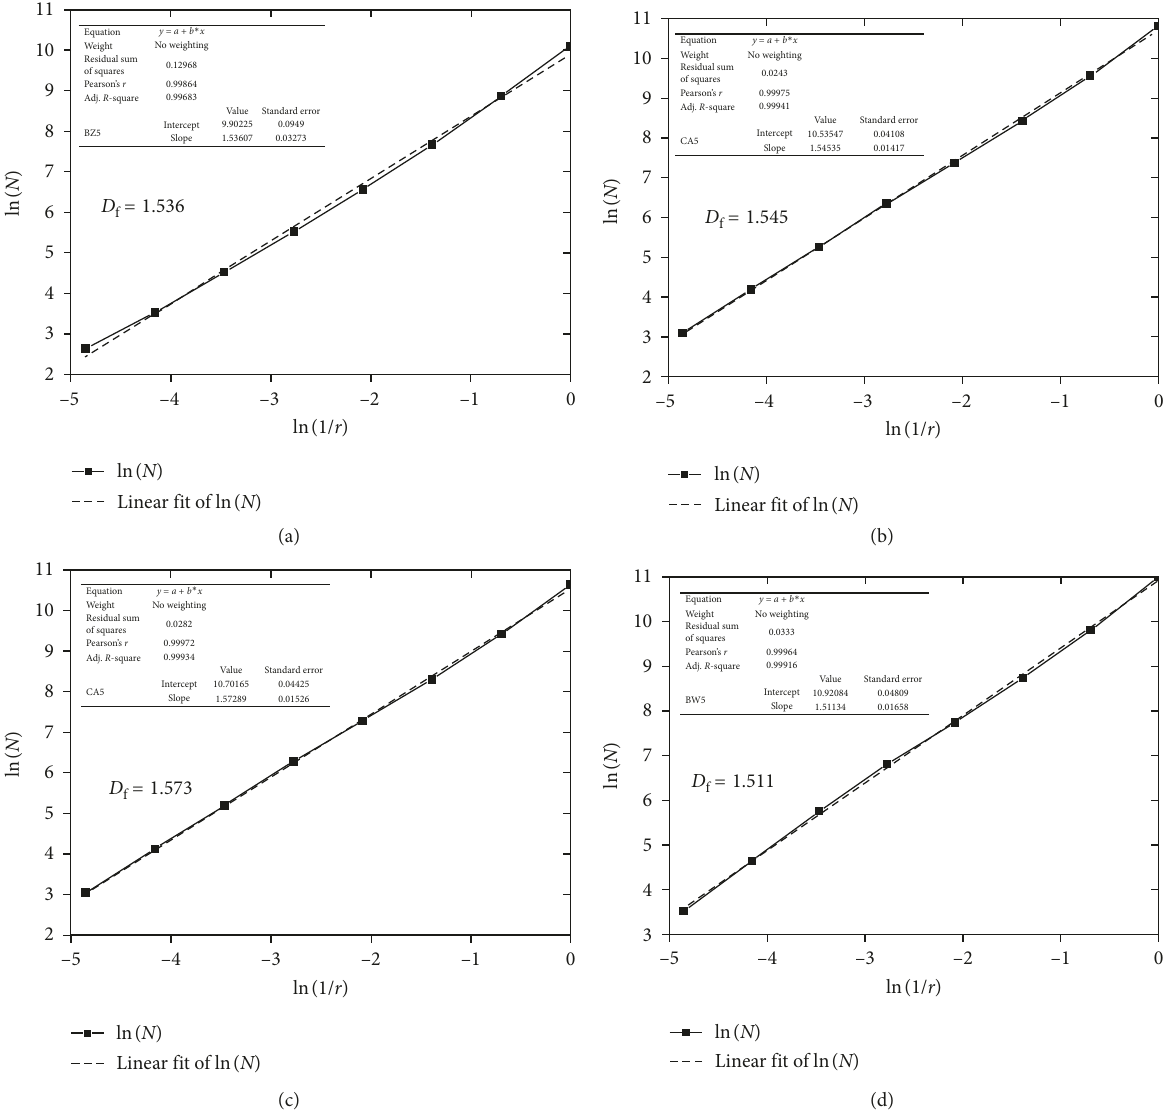
Figure 5: Schematic diagram for calculating D . Mining face 5-1 at a mining length of (a) 1200mm; (b) 1500mm; (c) 1800mm; (d) f